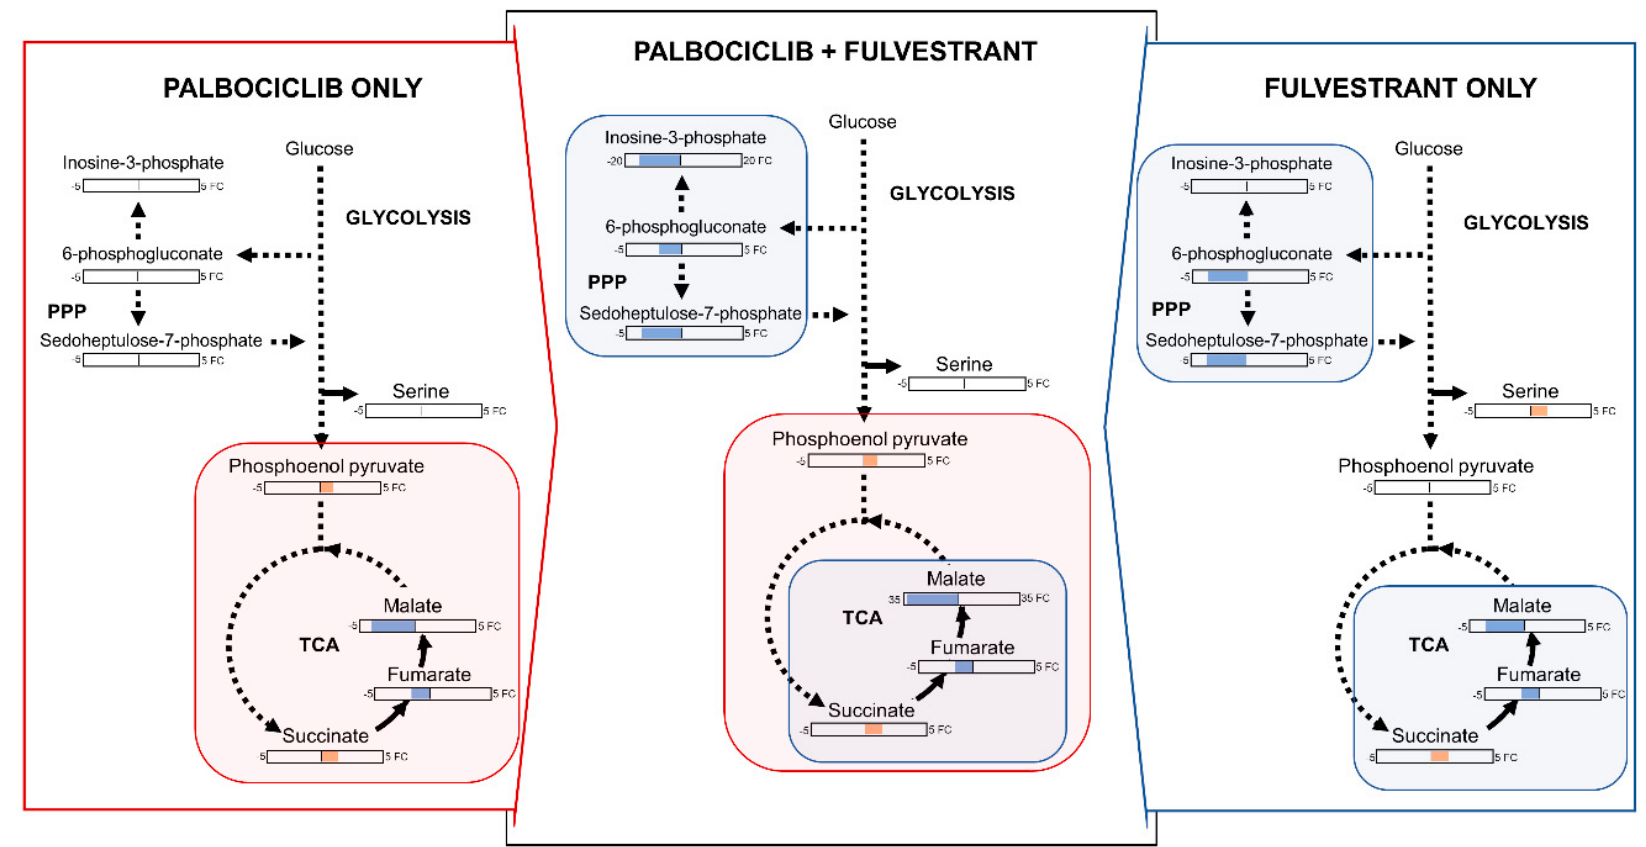
Figure 3. Overview of metabolite changes occurring in MCF-7 breast cancer cells two days post dosing with palbociclib, fulvestrant or in combination. Fold change values for significantly dysregulated metabolites ( p < 0.05) are reported in orange (increase) and blue (decrease).